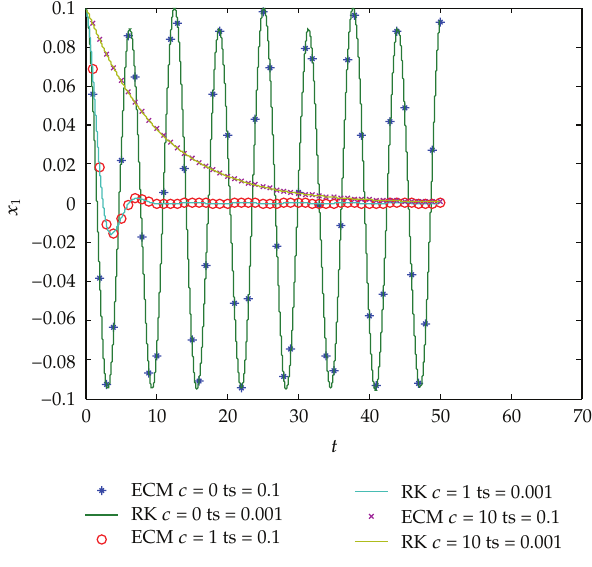
Figure 8: Displacement trajectory.